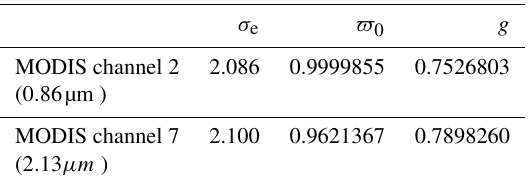
Table 1. Optical properties (extinction coefficient σ e , single- scattering albedo (cid:36) 0 and asymmetry parameter of the phase func- tion g ) of the ice crystal distribution used in this study, which as- sumes an effective radius of 10µm and an aggregate column shape provided by the Yang et al. (2013)